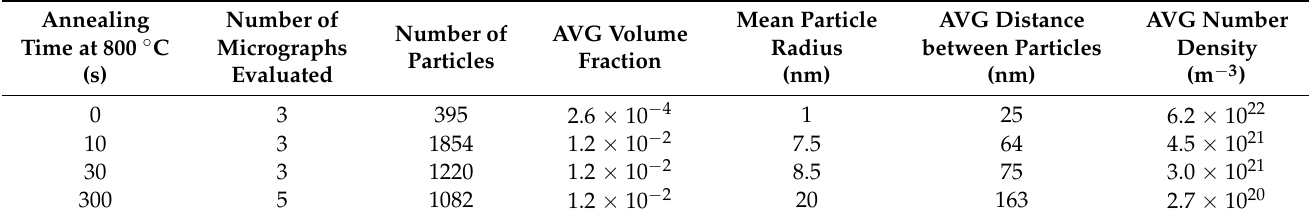
Table 1. Results of the quantitative particle